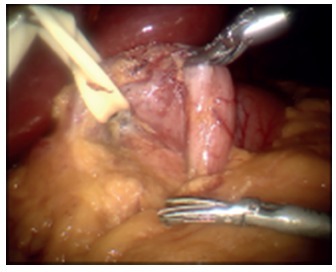
Placement of the Penrose drain at the duodenum